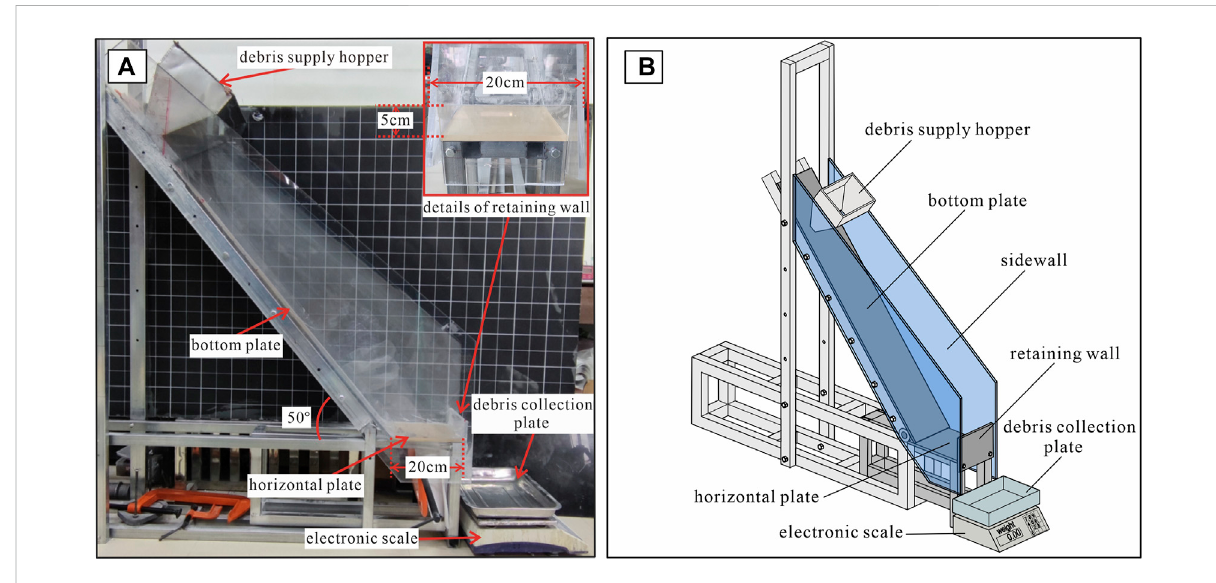
FIGURE 2 Model test equipment (A) photograph; (B) schematic